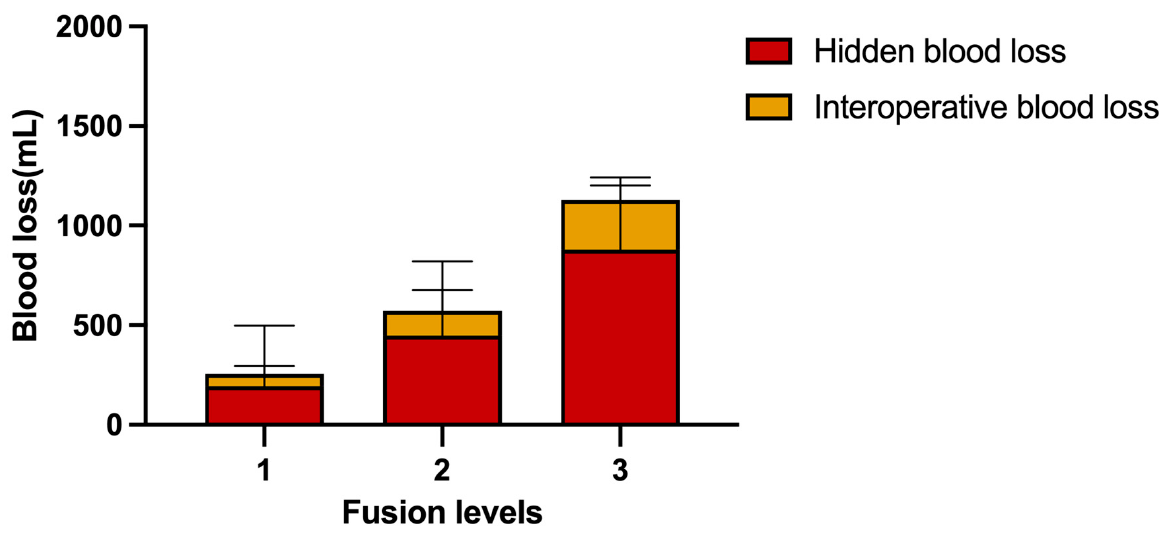
Figure 1. Mean blood loss between di ff erent fusion levels.